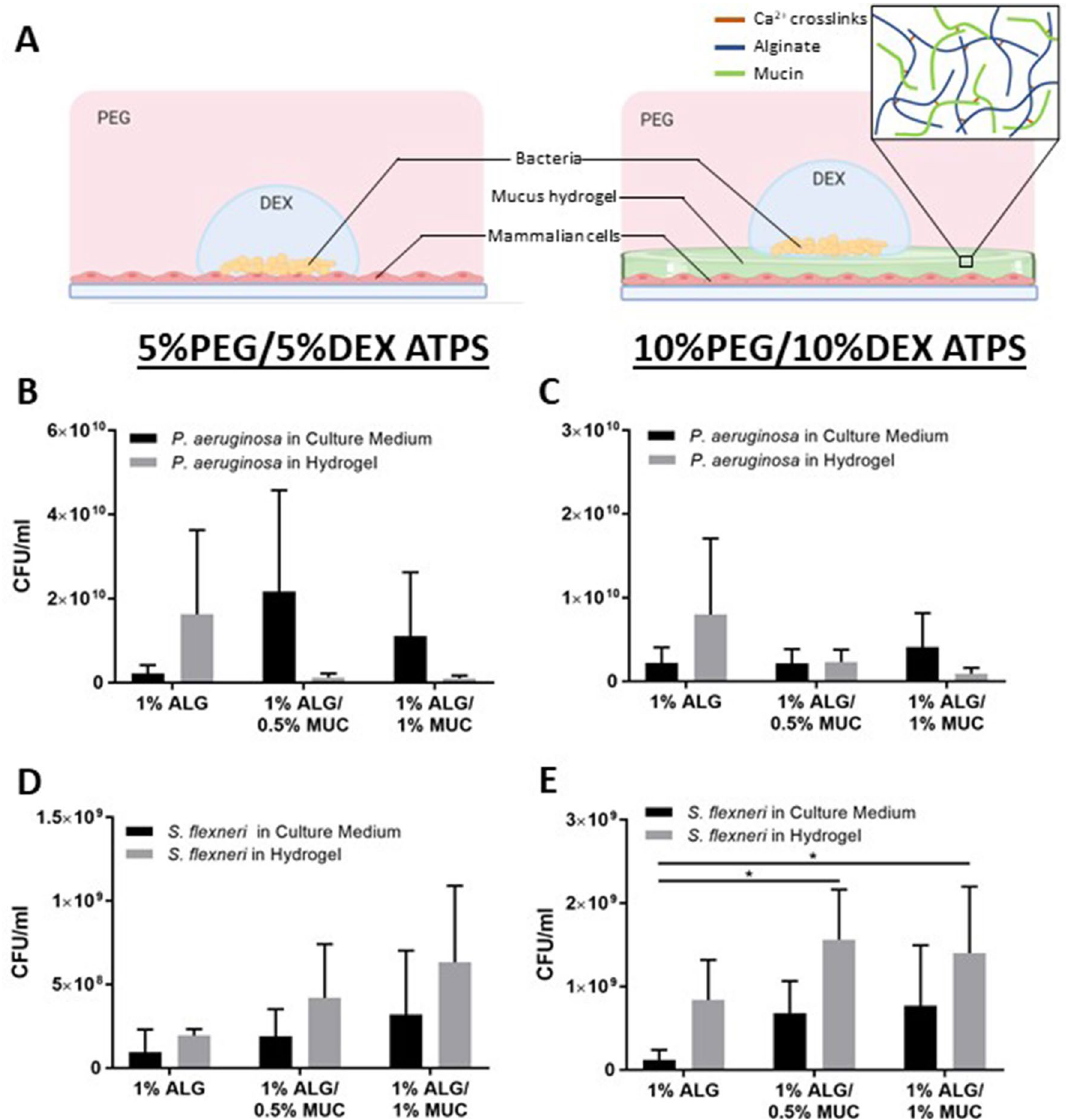
Figure 1. P. aeruginosa and S. flexneri abundance (CFU/ml) within the culture medium or hydrogel layer after 12 h of co-culture with 16-HBE and Caco-2, respectively. ( A ) Illustration of a PEG-DEX ATPS mammalian– microbial co-culture without (left) and with (right) an engineered mucus hydrogel layer, illustrating all potential crosslinking interactions within the mixed ALG-MUC hydrogel network. CFU/ml values of P. aeruginosa grown in either a 5%PEG/5%DEX ATPS ( B ) or 10%PEG/10%DEX ATPS ( C ), and S. flexneri in a 5%PEG/5%DEX ATPS ( D ) or 10%PEG/10%DEX ATPS ( E ), where *indicates p < 0.05 (n = 16-HBE cells were co-cultured with P. aeruginosa , the level of cell death was found to be negatively correlated with increasing mucin concentrations within the alginate-based hydrogels, for both the 5% and 10% PEG-DEX ATPS (Fig. 3). Caco-2 cells, on the other hand, showed higher proportions of live cells when S. flexneri were deposited on top of all hydrogel formulations (Fig. 3). With the introduction of the ciprofloxacin supplemented PEG-phase, the survival of 16-HBE cells seemed to be improved in co-cultures containing a 1% ALG hydrogel overlay (5% and 10% PEG-DEX ATPS). How- ever, 16-HBE cell viability seemed to be less than what was observed when no antibiotic was supplemented in co-cultures containing ALG-MUC hydrogel (1% ALG/0.5% MUC and 1% ALG/1% MUC) overlays (Fig. 4). Similarly, this was observed for Caco-2 cells grown in a 5% PEG/5% DEX ATPS but not the 10% PEG/10% DEX ATPS, where Caco-2 cells showed similarly high levels of live mammalian cells cultured under all hydrogel formulations (Fig. 4). Polyethylene glycol has previously been shown to have cytotoxic effects towards mammalian cells in a molecu- lar weight dependent manner 18 . Therefore, to demonstrate that the observed cell death was not due to the PEG or the alginate-based (1% ALG, 1% ALG/0.5% MUC, and 1% ALG/1% MUC) hydrogels, 16-HBE cells were incubated with a hydrogel overlay in either normal culture media (RPMI) or a PEG-rich phase (5% and 10%)